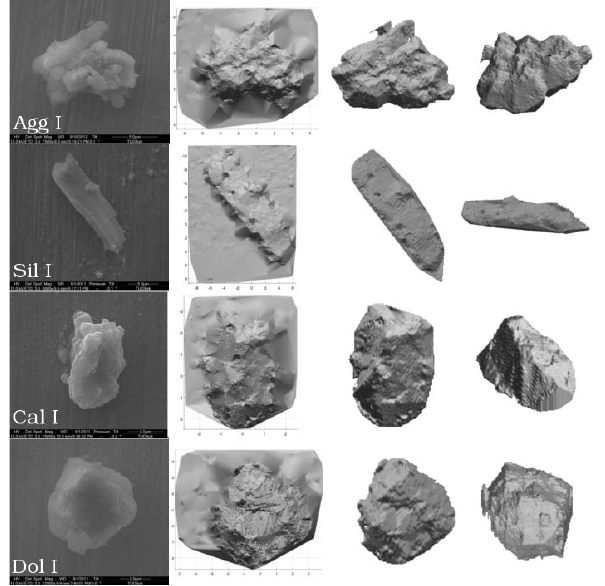
Fig. 1. Mineral dust particles used in this study (from left to right): scanning-electron microscope images, the retrieved TIN model of the surface, and the final volume representation from two different viewing